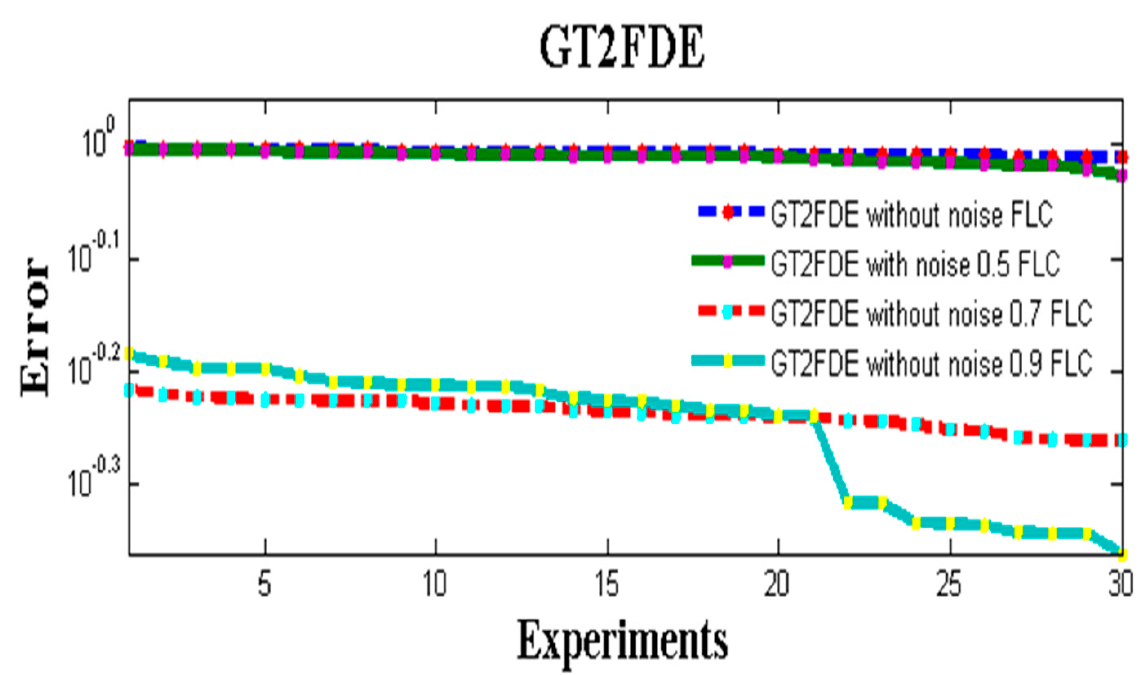
Figure 21. Graphical representation of the error using GT2FDE without noise and with different noise levels.